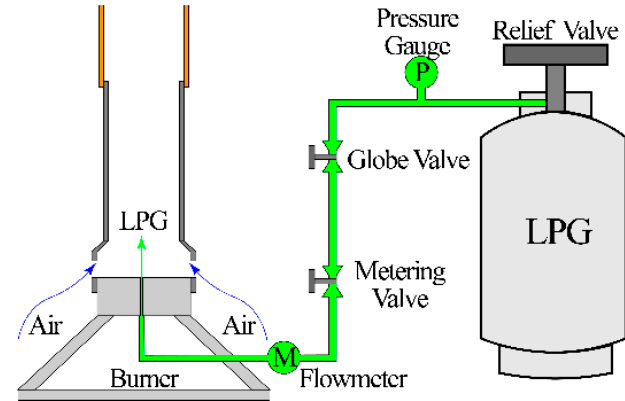
Figure 1. Schematic of the Bunsen burner.